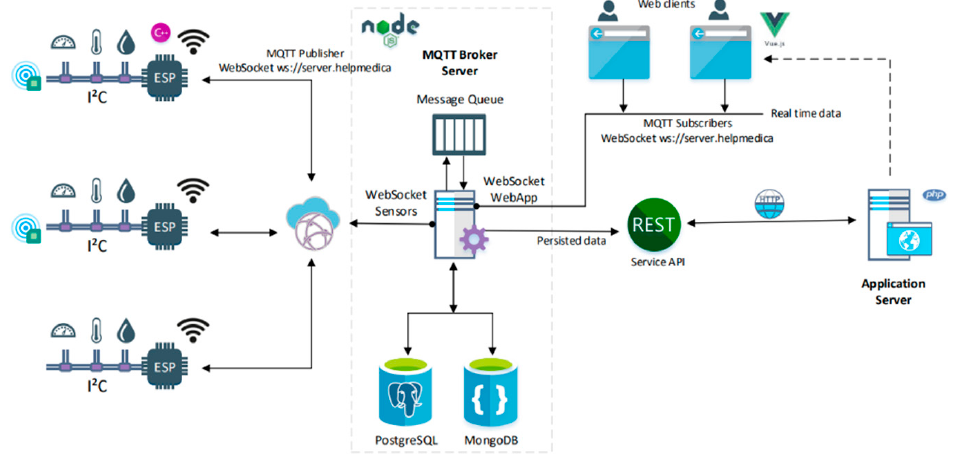
Figure 10. Hardware Component Diagram.